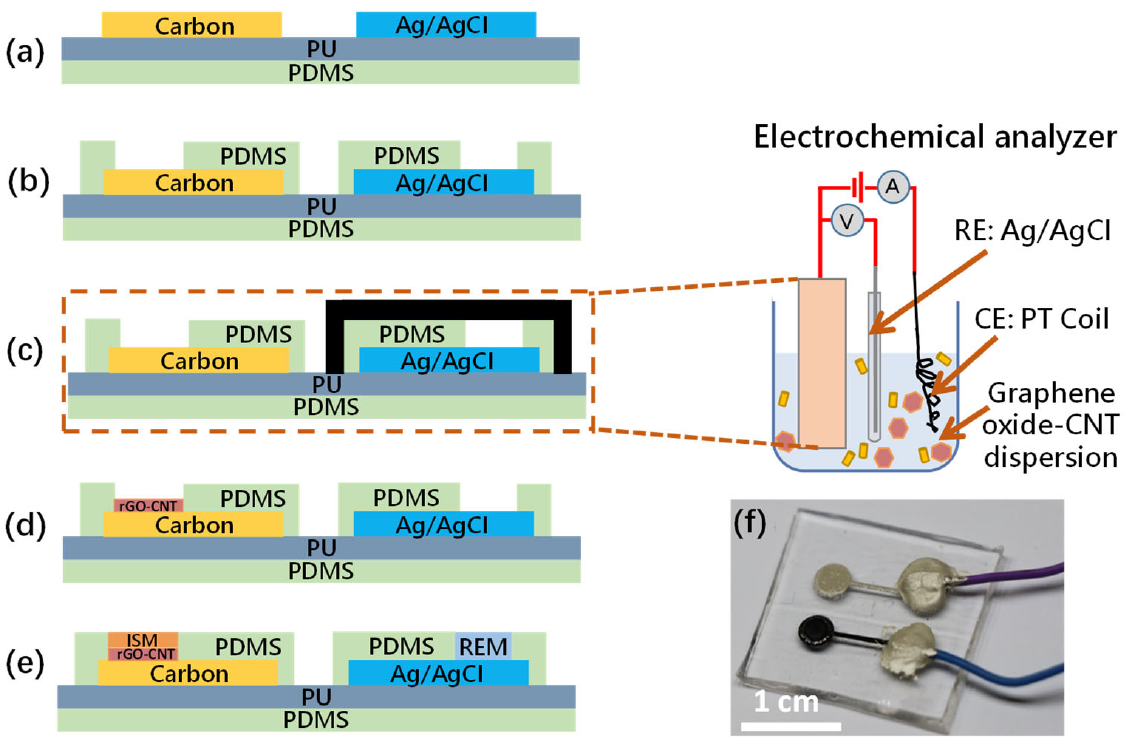
Figure 1. Fabrication process flow of the stretchable electrochemical sweat sensor: ( a ) Screen printing of the Carbon and Ag/AgCl layers on a PU-PDMS substrate; ( b ) Screen printing an additional PDMS layer to act as the electric insulator; ( c ) Electrochemical deposition of the Graphene–CNT layer at − 1.22 V using an electrochemical analyzer, with the protection of the screen-printed refer- ence electrode on the substrate by tape; ( d ) the 3D Graphene–CNT layer was formed on the screen- printed carbon electrode; ( e ) Forming the ISM by the drop-casting method; ( f ) The fabricated sensor bonded with wires.